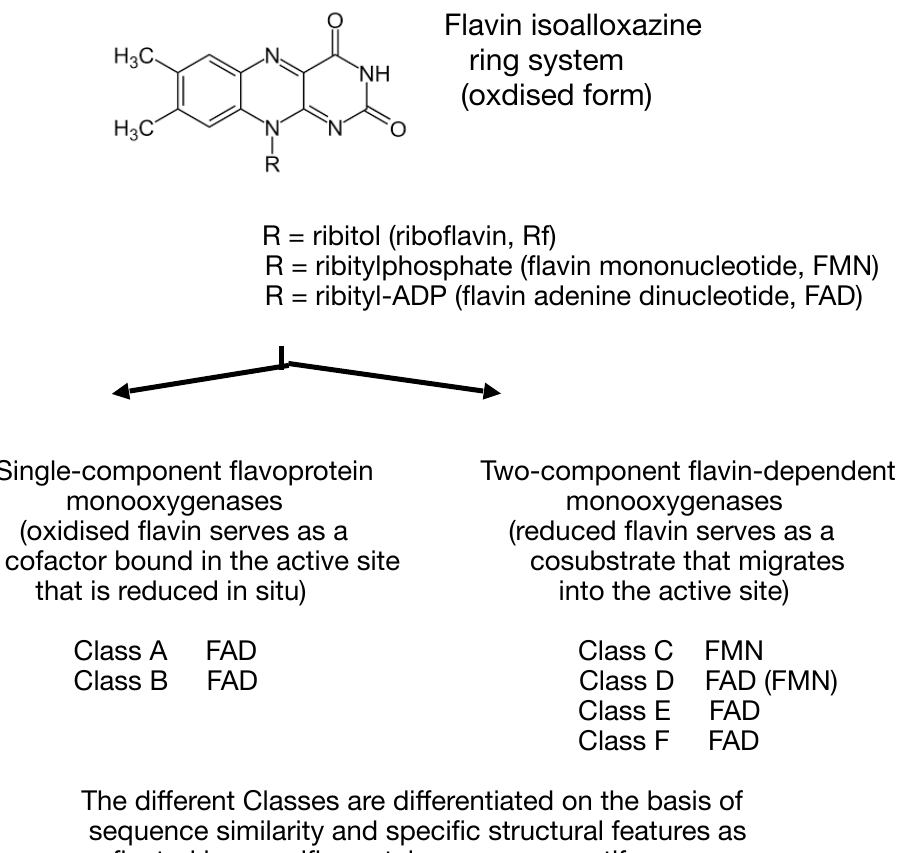
Figure 1. Structure of the flavins and the major enzyme classes they support. The first flavin-dependent enzyme to be studied in any detail was in fact not a monooxygenase, but an oxidoreductase isolated from the bottom fermenting yeast Saccha- romyces carlsbergensis that was convincingly confirmed to be a true flavoprotein in the early 1930s [5]. Because of that historical significance, the enzyme subsequently became widely referred to as Old Yellow Enzyme (OYE, [6]), yet more than 80 years after it was first studied, aspects of the biochemistry and functionality of that originally discovered true flavopro- tein and its homologues remain enigmatic [7]. Similarly, 2,5- and 3,6-diketocamphane monooxygenase (2,5- and 3,6-DKCMO), which are isoenzymic Class C fd-TCMOs coded for by corresponding genes located on the large 533 kb CAM plasmid of Pseudomonas putida ATCC 17453 [8], are also characterised by an equivalent chequered history that spans almost six decades. These enzymes, which play key enantiocomplementary enabling roles in the degradation by the bacterium of the two isomeric forms of the naturally occurring C10 bicyclic terpene camphor (Figure 2), were first studied in the early 1960s [9]. The protracted emergence of our fuller current understanding of both the form and function of the DKCMOs has been influenced by a cocktail of contributory factors, some positive (including the evolution of more relevant concepts and ideas, plus the development of more refined techniques, allied to more powerful instrumentation), some negative (including misinterpretation, both of de novo data and extant literature) and, perversely, some of the most important by pure serendipity. The catalogue of relevant events represents not only a paradigm of the way science in general progresses (evidenced typically by the discovery of the true structure of DNA [10]), but also serves to emphasise the idiosyncratic episodic e.